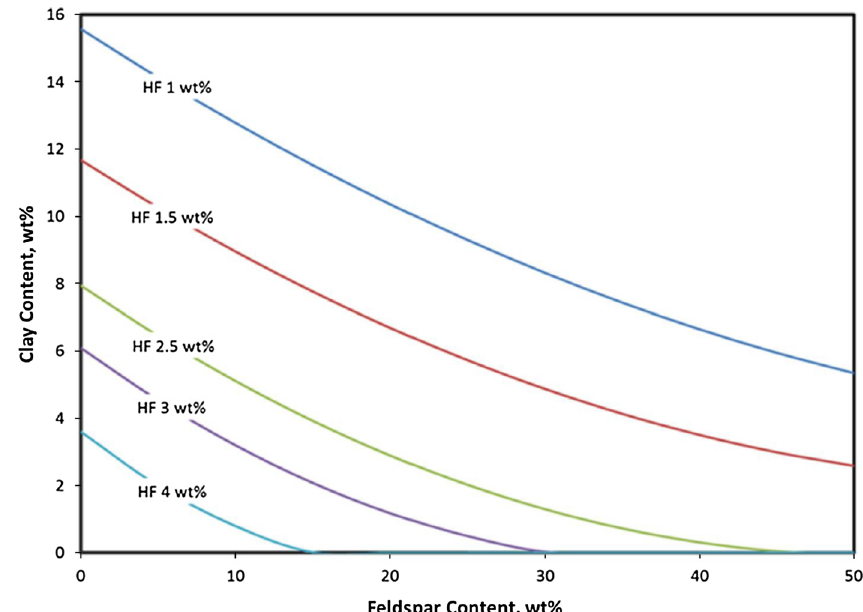
Fig. 7 Optimum HF concentra- tion based on mineral content determined by Abdelmoneim and Nasr-El-Din